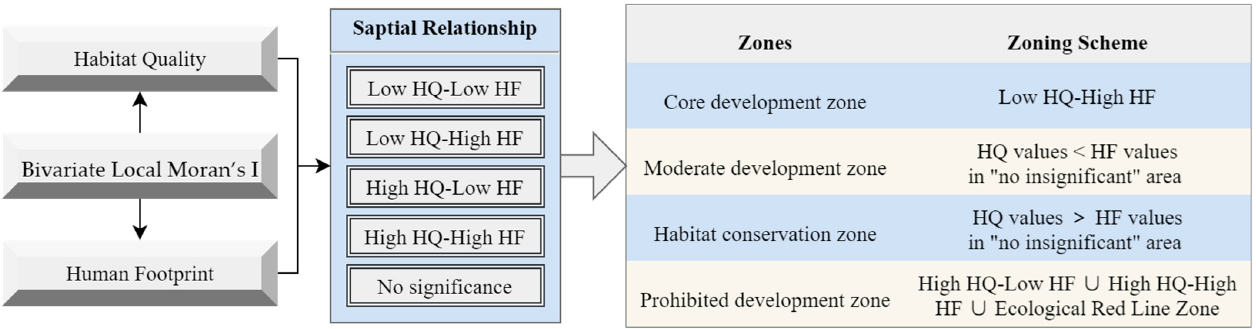
Figure 3. Spatial zoning scheme for the territory of Guiyang city.